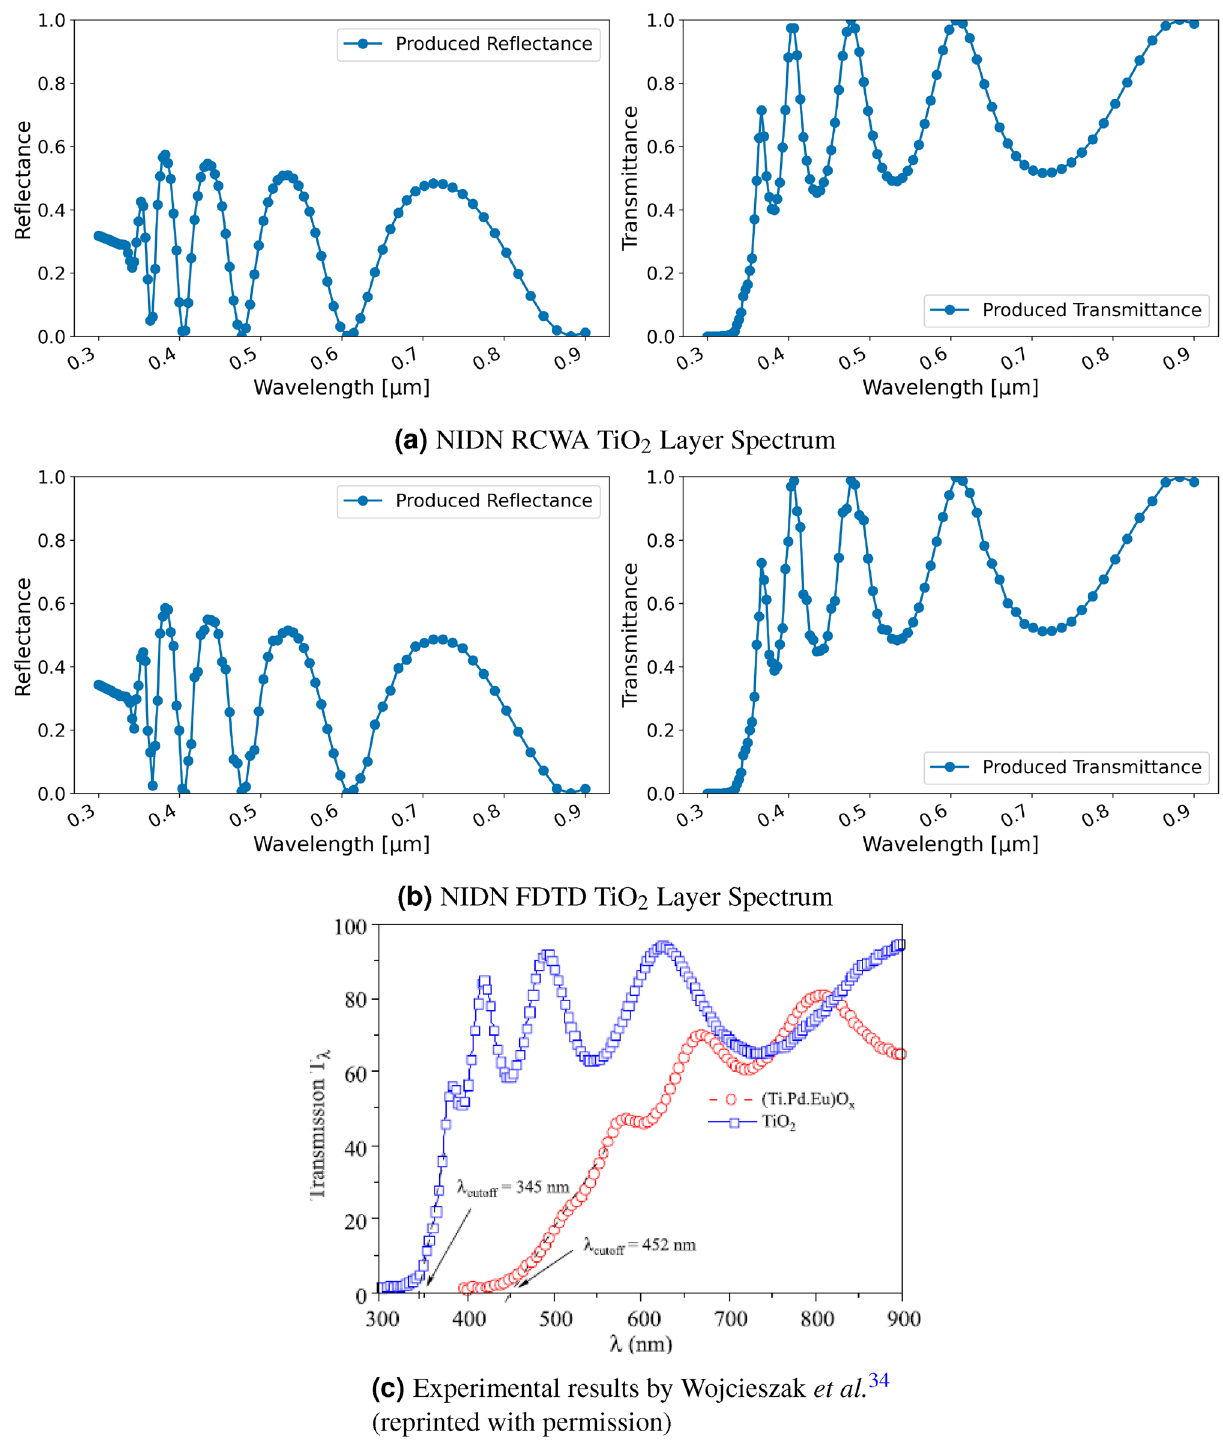
Figure 2. Comparison of the transmittance of a 380 nm thick layer of TiO 2 in NIDN and experimentally